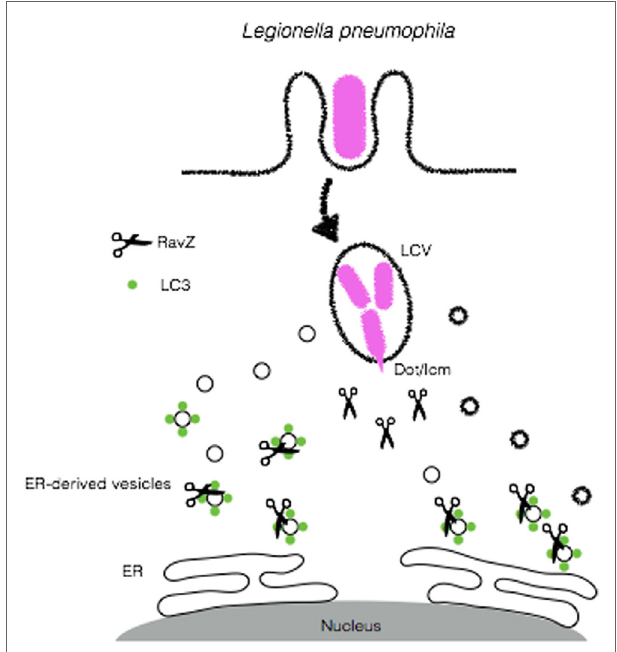
FigURe 6 | Legionella pneumophila disrupts autophagy to create a replicative niche. L. pneumophila secretes RavZ through its Dot/Icm apparatus in order to deconjugate LC3 from ER-derived vesicles and block autophagy in order to escape from autophagic